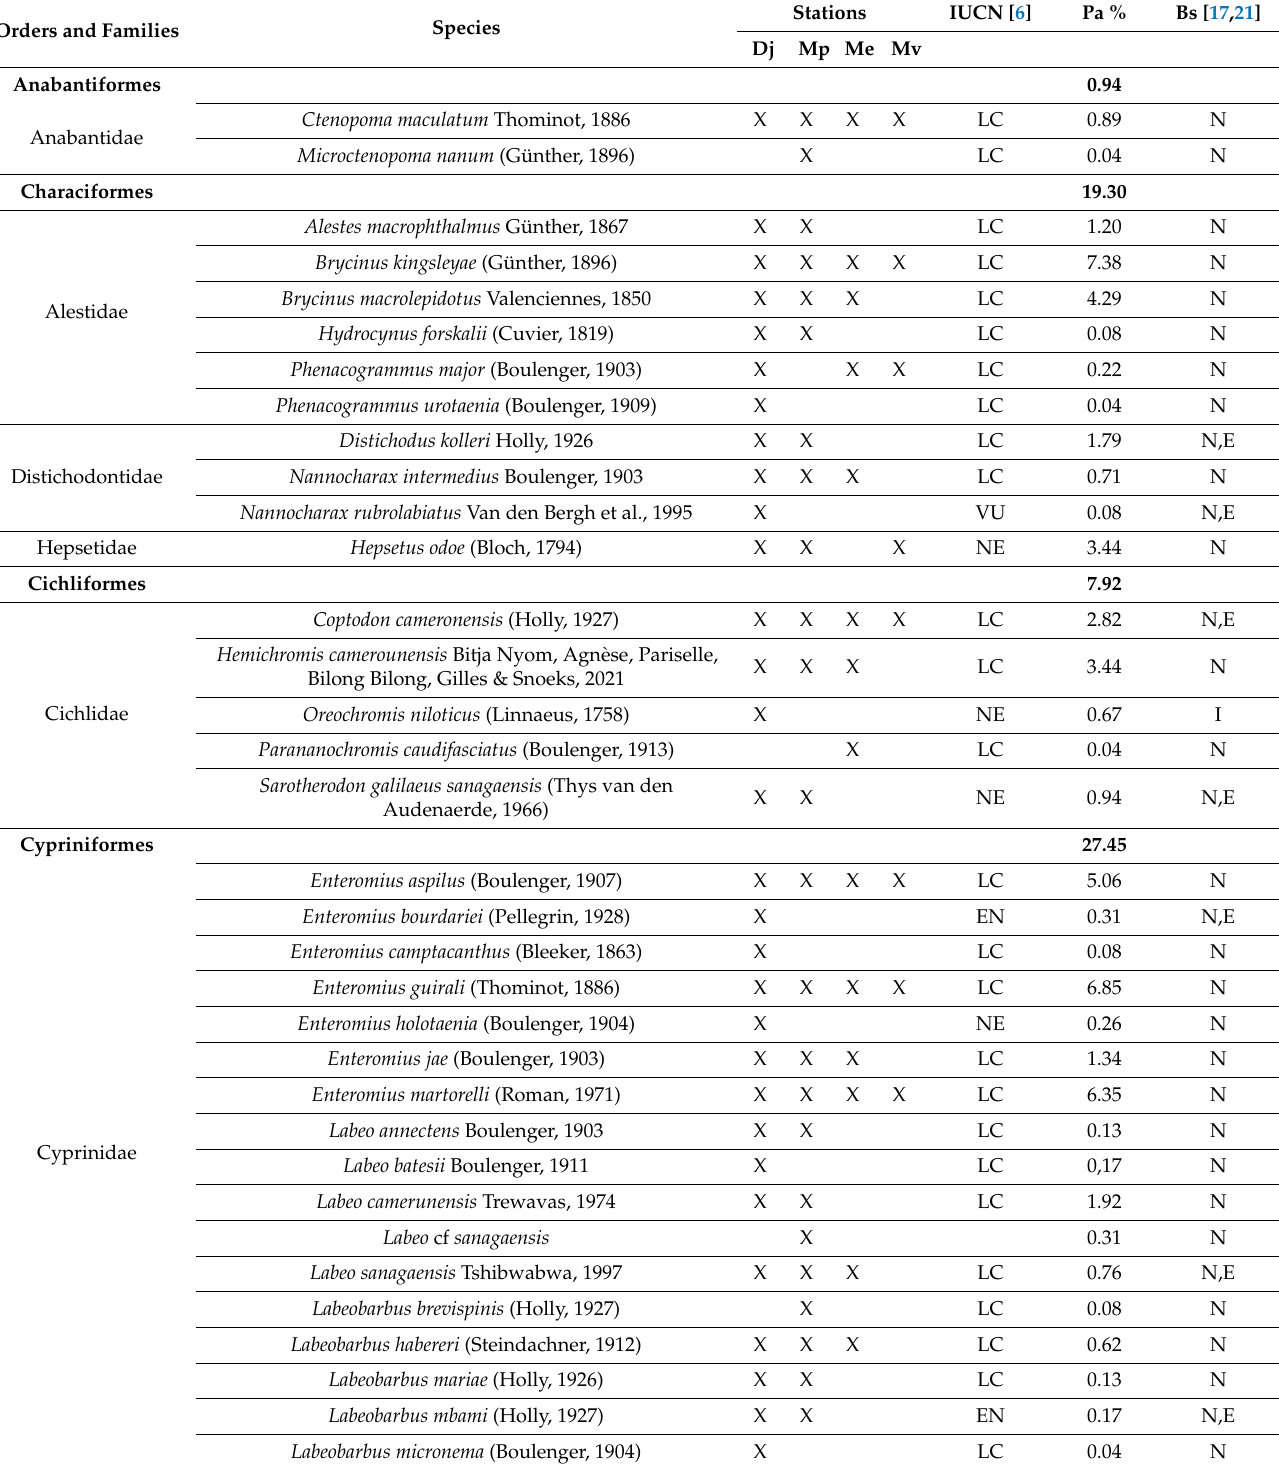
Table 3. List of fish taxa inventoried in the MpDNP: Dj = Djim River, Mp = Mpem River, Me = Mey River, Mv = Mvouring River; IUCN status: LC = Least Concern, VU = Vulnerable, NE = Not Evaluated, EN = Endangered, DD = Data Deficient; presence (X) or absence (empty); E = endemic (to the Sanaga River basin), N = native (indigenous to the Sanaga River basin, but present elsewhere as well); I = introduced (and non-native to the Sanaga River basin); Pa = percentage abundance; Bs = Biogeographic